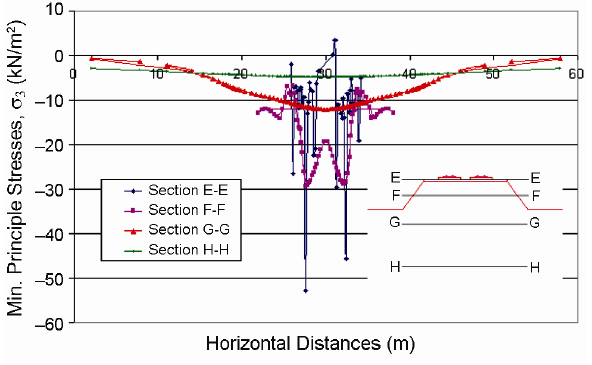
Fig. 8. Distribution of minimum principal stresses (σ 3 )